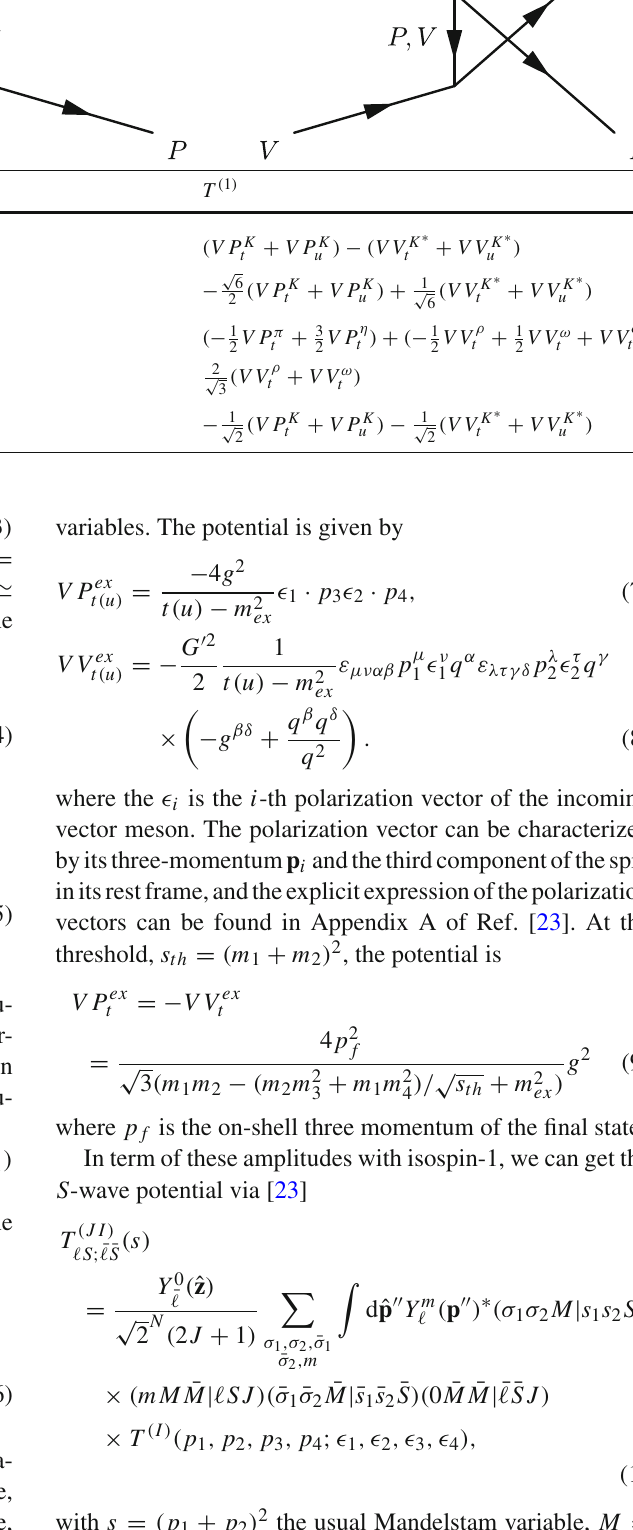
Fig. 1 The t - and u -channel Feynman diagrams